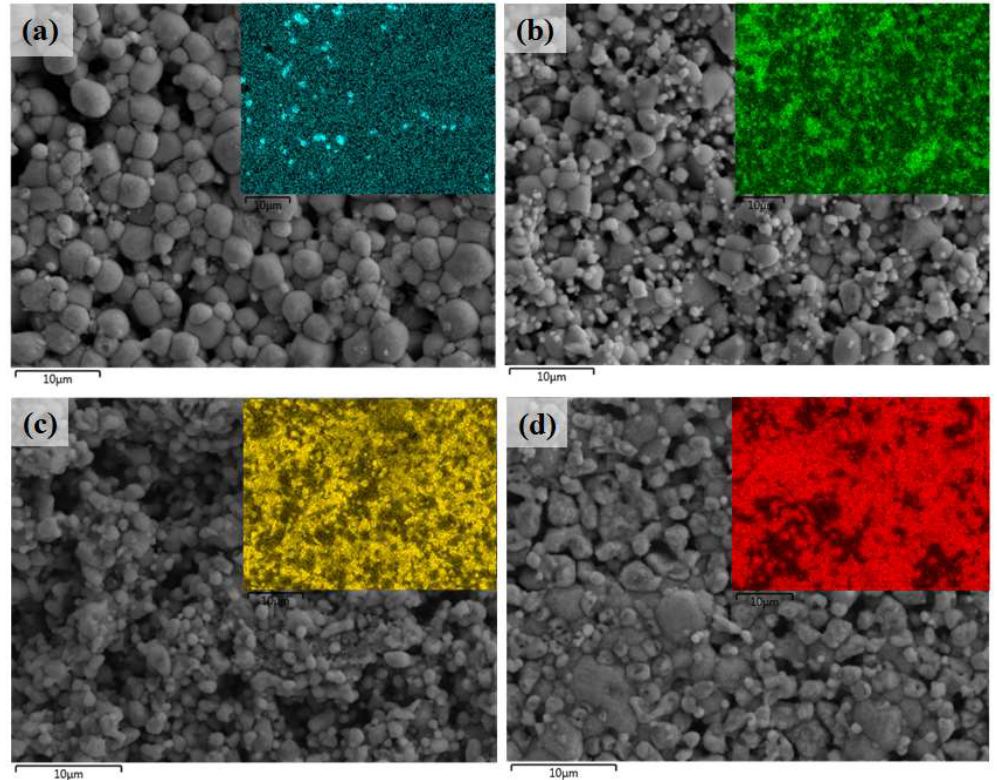
Figure 5. Images of the surface morphology and map of Ni-distribution for the reduced (1 − x)Sr 2 Mg 0.25 Ni 0.75 MoO 6 − δ + xNi ceramic materials: x = 15 ( a ), x = 30 ( b ), x = 70 ( c ) and x = 85 ( d ).